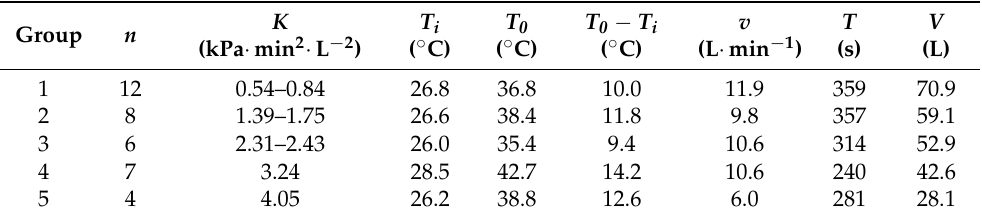
Table 2. Showerhead operating parameters (one ‐ week).